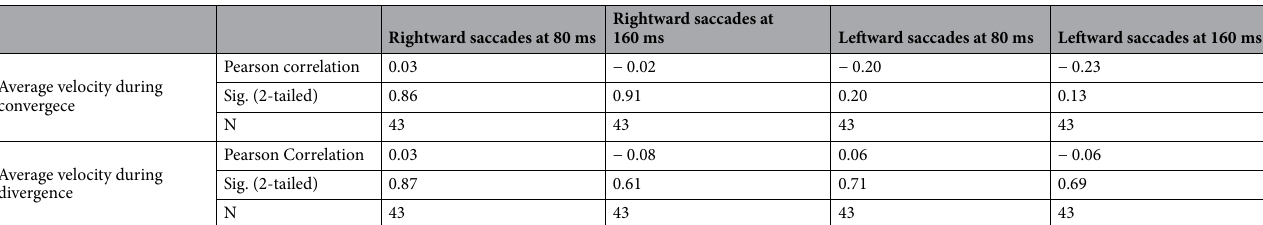
Table 5. Correlation between average velocity of convergence and divergence and speed of rightward and leftward saccades at 80 ms and 160 ms for healthy participants. Variables with significant differences between the two populations (p < 0.05) are bolded.